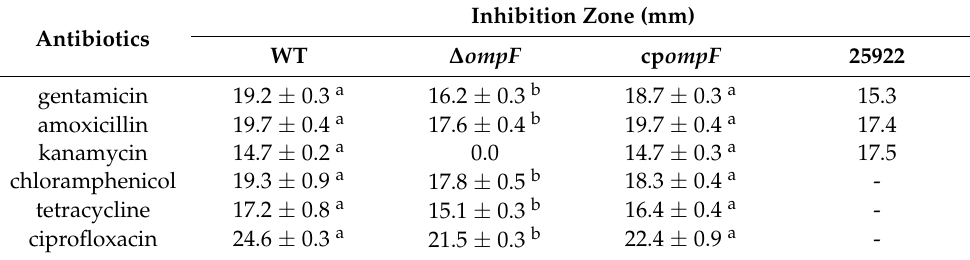
Figure 7. Antibiotic resistance of the C. sakazakii WT, ∆ ompF and cp ompF strains. ( a ) 1, 2, 3 and the corresponding positions on the other plates represent gentamicin, ampicillin and penicillin, respectively; ( b ) 4, 5, 6 and the corresponding positions on the other plates represent tetracycline, ciprofloxacin and kanamycin, respectively. Table 2. Different antibiotic resistance of C. sakazakii WT, ∆ ompF and cp ompF strains from the size of inhibition